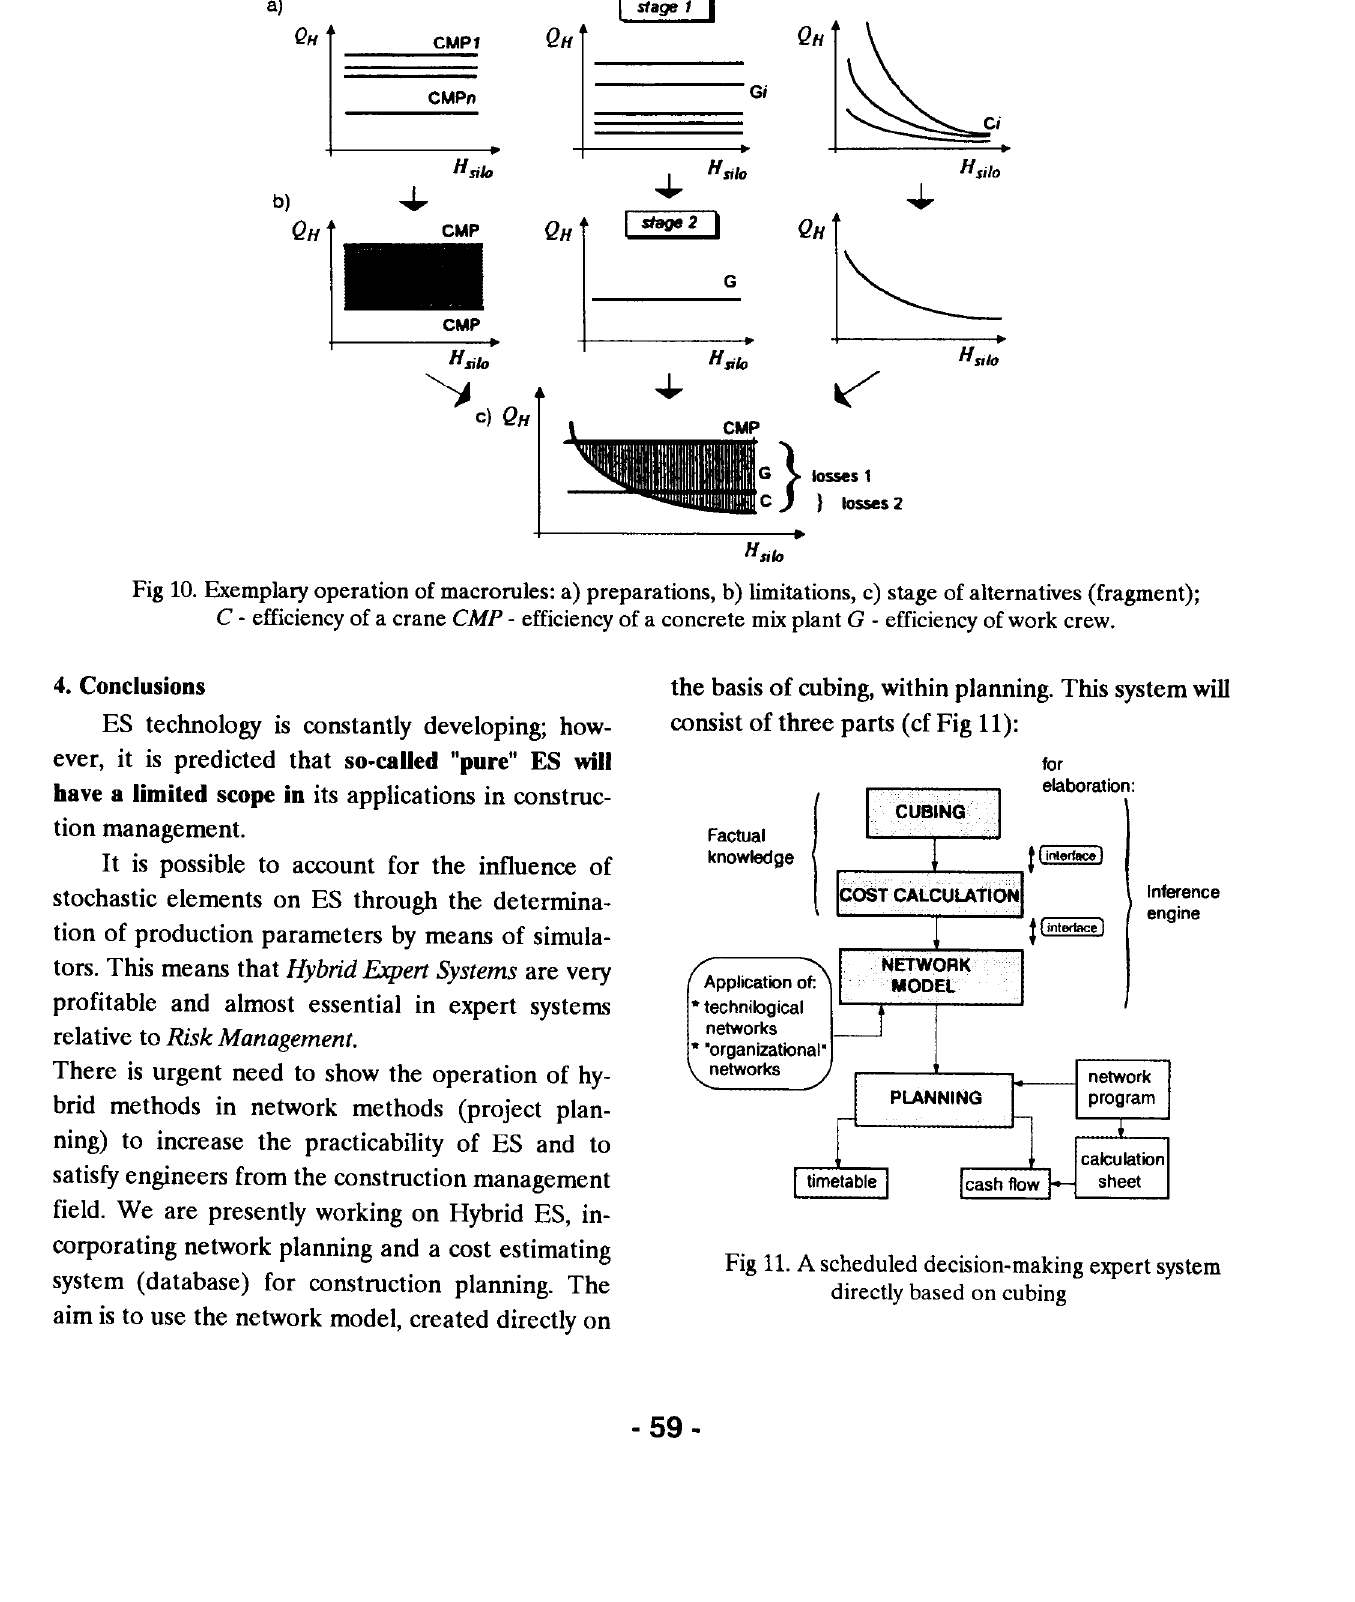
Fig 11. A scheduled decision-making expert system directly based on